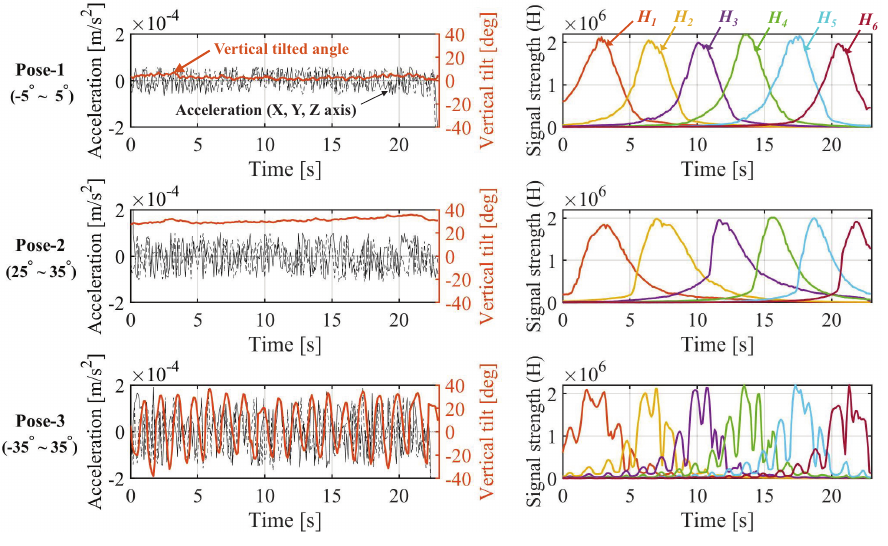
Figure 11. Part of the measurement data according to different